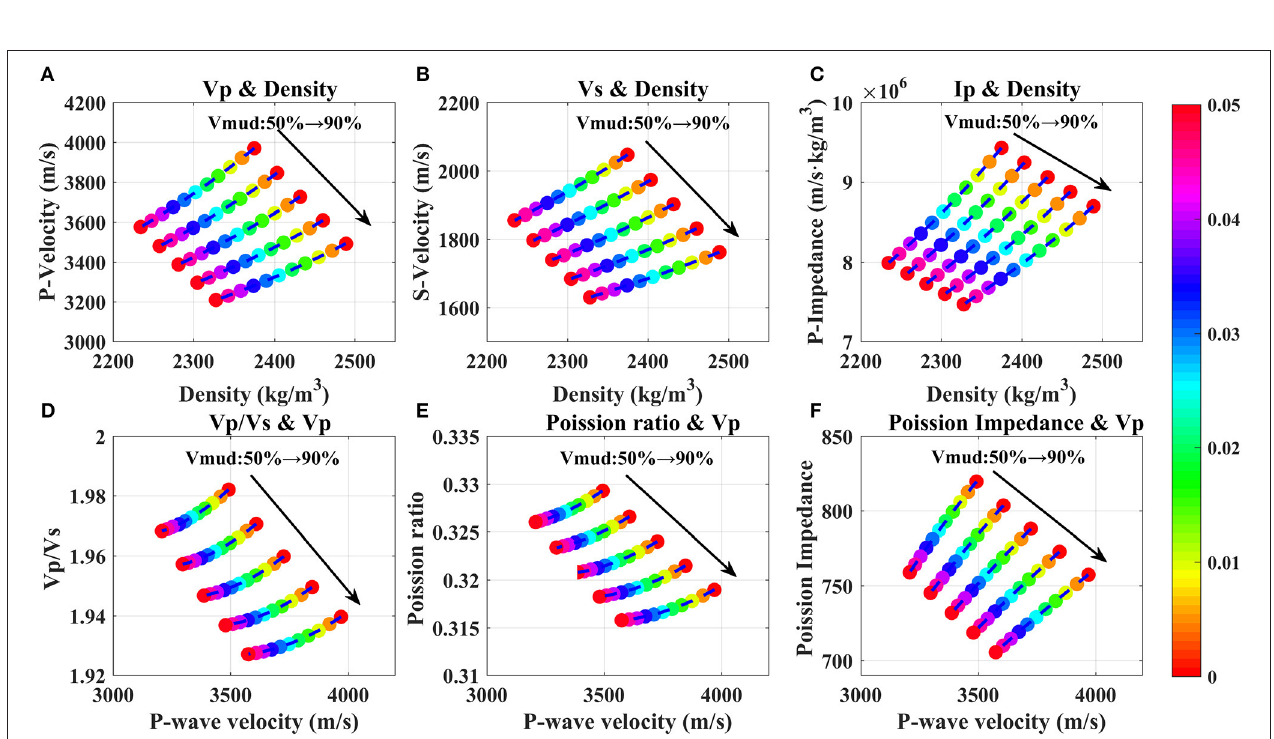
FIGURE 7 | Crossplot of elastic parameters versus TOC content at different mud content based on the rock physical model of the mud-rich source rock. (A) V p and ρ , (B) V s and ρ , (C) I p and ρ , (D) V p / V s and V p , (E) Poisson’s ratio and V p , (F) Poisson impedance and V p . The color bar on the right represents the TOC content.